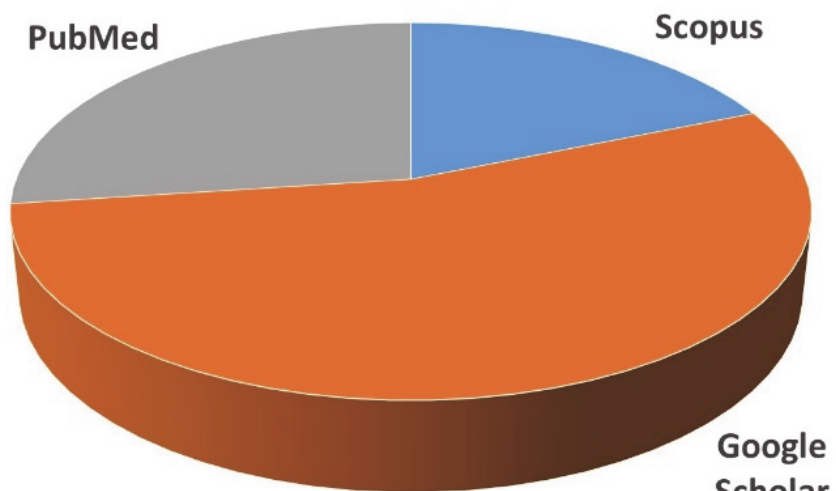
Figure 1. The number of articles from different sources.